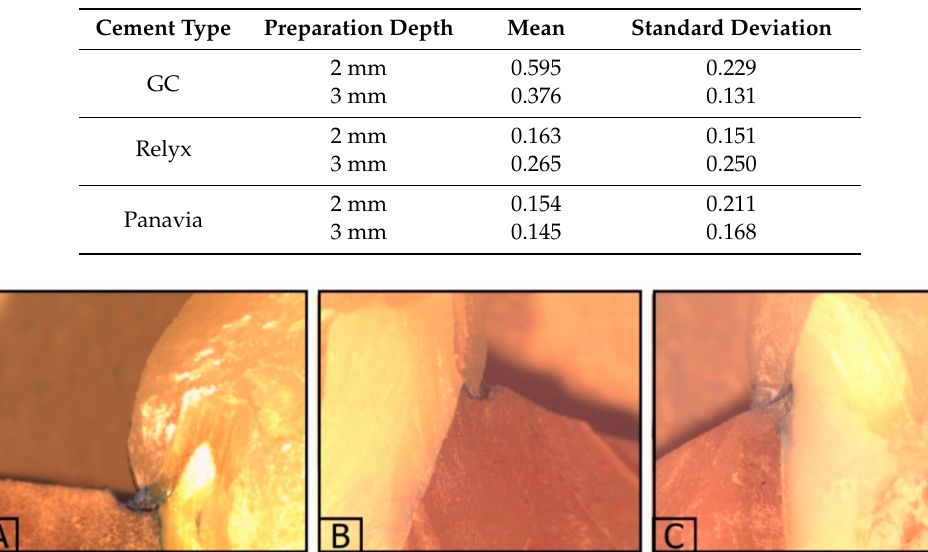
Figure 4. Microleakege evaulation of endocrowns by stereomicroscope: ( A ) Dye penetration for GC cement; ( B ) dye penetration for Panavia V5 cement; ( C ) dye penetration for Relyx Ultimate